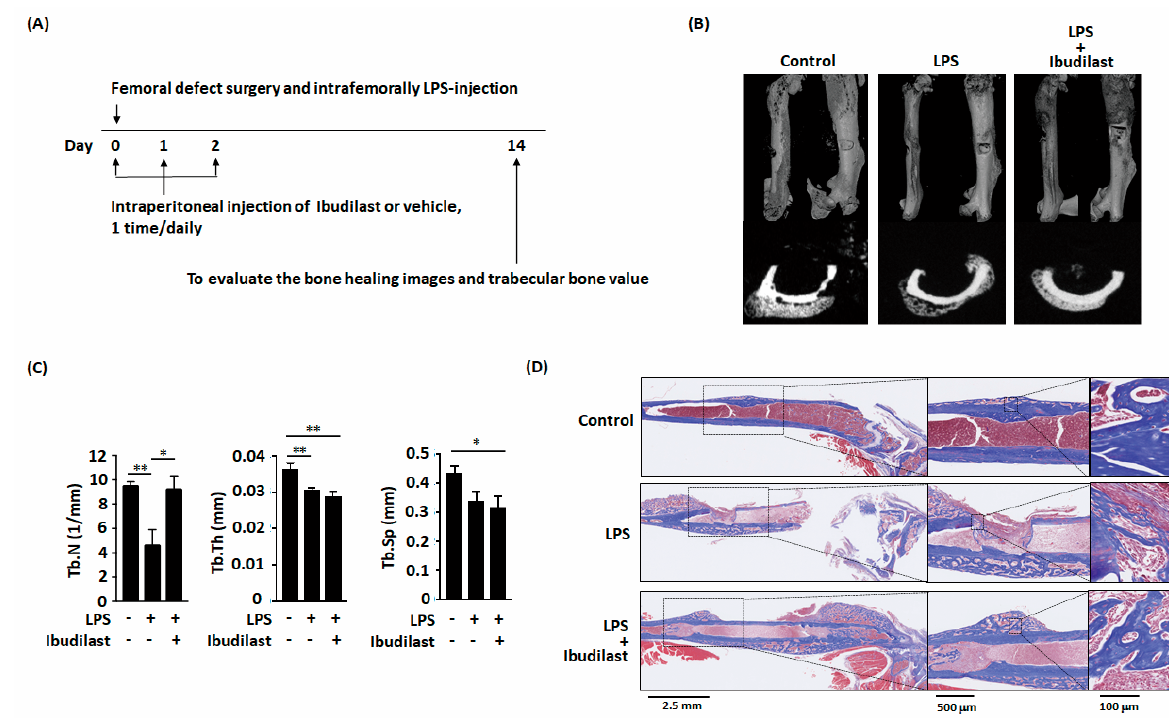
Figure 5. Ibudilast prevents LPS-induced decreases in trabecular number in vivo. ( A ) Schematic representation of the experimental setup. ( B , C ) MicroCT three-dimensional image and transverse images of the bone defect site show that Ibudilast reversed the LPS-induced decrease in trabecular number in vivo. ( D ) Ibudilast not only promoted bone bridge formation but also promoted mature osteocyte formation. Data are presented as the mean ± standard error of the mean. Analyses were conducted with two-way analysis of variance followed by Bonferroni’s post-hoc test. * p < 0.05, ** p < 0.01. Abbreviations: LPS, lipopolysaccharide; Tb.N, trabecular number; Tb.Th, trabecular thickness; Tb.Sp, trabecular separation. Sham, n = 5; LPS, n = 7; and LPS + Ibudilast, n = 5.